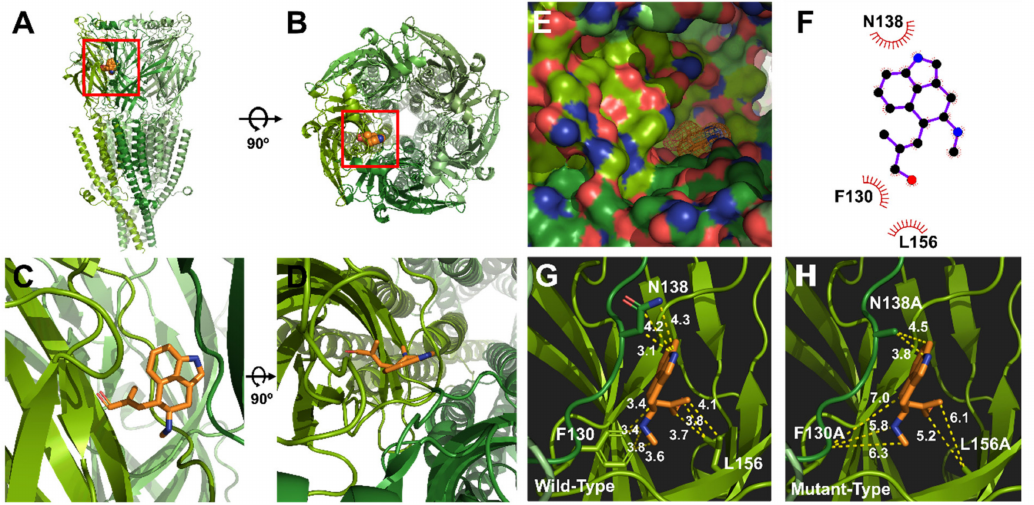
Figure 5. Molecular docking modeling of chanoclavine to the 5-HT 3A receptor. ( A – D ). Side and top views of the chanoclavine docking model to the 5-HT 3A receptor. ( E ). Binding pocket in the 5-HT 3A receptor region of the extracellular domain membrane of the pocket side. Chanoclavine docked to the extracellular region that forms a loop complex in the 5-HT 3A receptor. ( F ). 2D schematic of the predicted binding mode of chanoclavine in the ligand-binding pocket. ( G , H ). Binding interactions of the ligand and residues in the wild and mutant types. The replaced mutants changed the interaction activity to varying